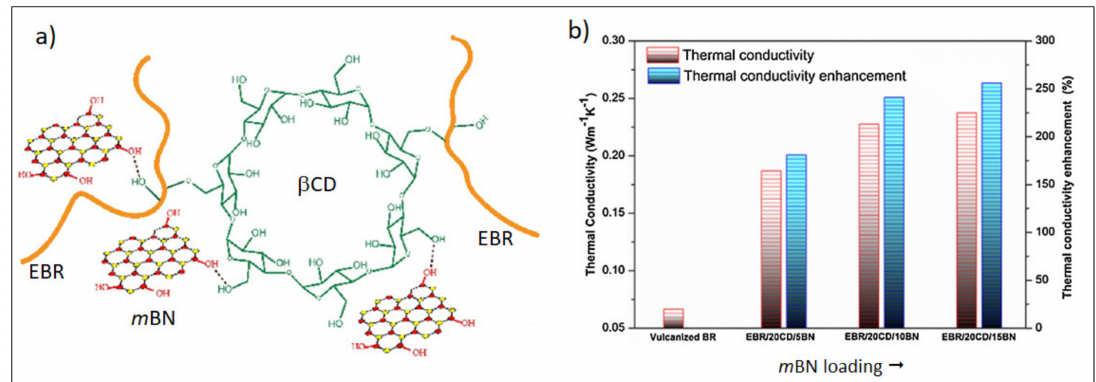
Figure 17. ( a ) Mechanism of the generation of EBR/ β CD/ m BN nanocomposites; ( b ) Trend of the thermal conductivity for vulcanized BR and EBR-based nanocomposites at 25 ◦ C. Adapted from [182]. Copyright© 2021 Elsevier Ltd. All rights